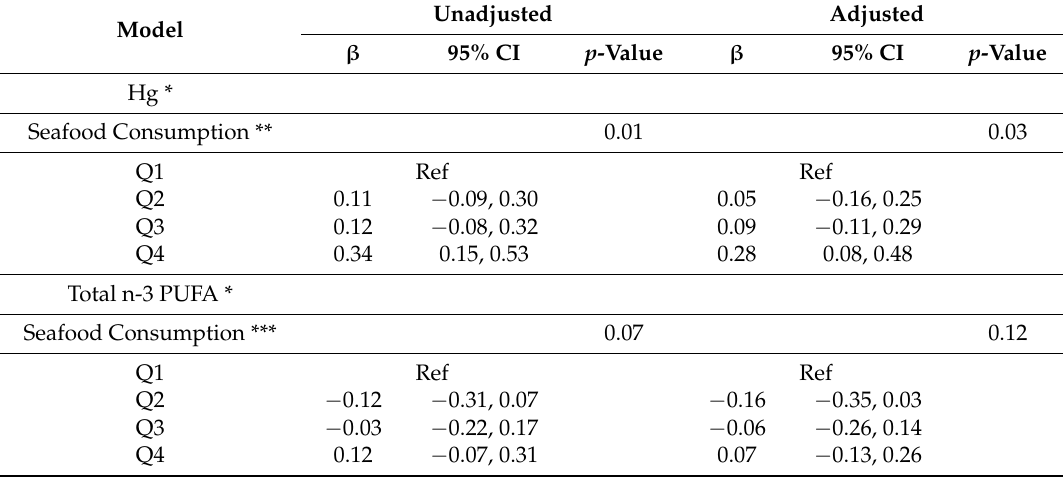
Table 5. Linear regression models modeling for seafood consumption (measured in quartiles of ounces of seafood consumption per month) as a predictor for blood levels of Hg and total n-3 PUFA.